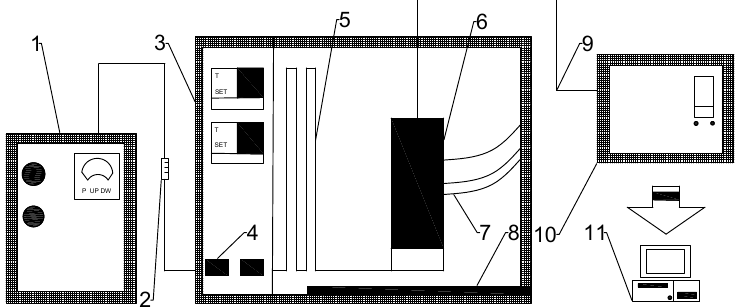
Figure 1. Programmed temperature rise—gas chromatography system. The collected gases were collected and analyzed using a gas chromatograph. The ex- perimentally measured oxygen concentration data with temperature are shown in Figure 2.